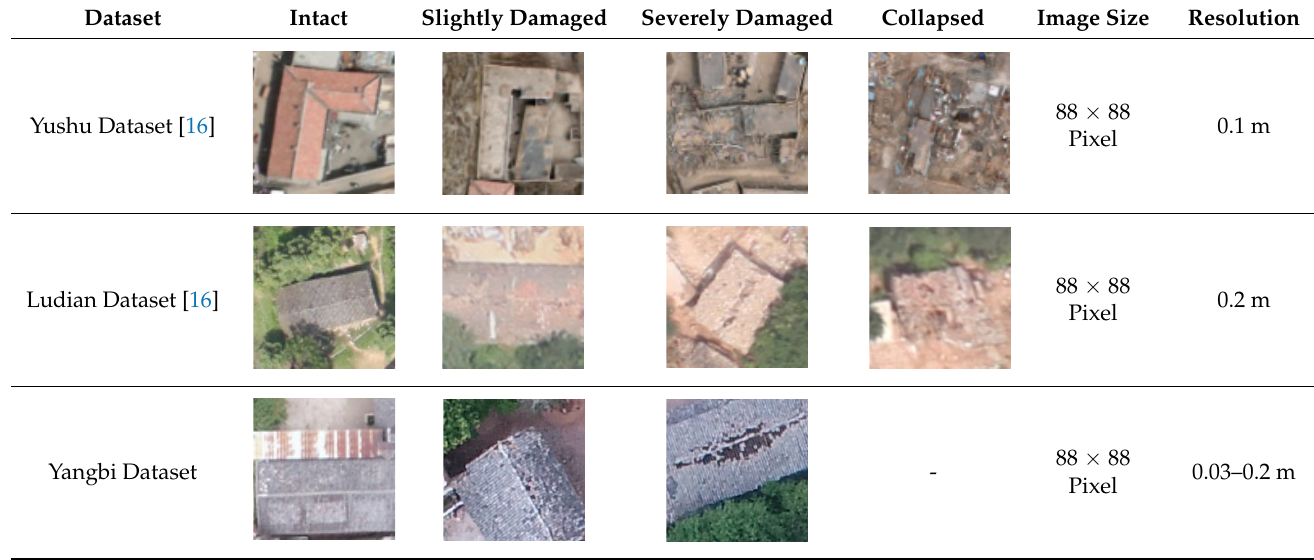
Table 2. Statistics on the number of buildings sampled in the datasets with the four levels of